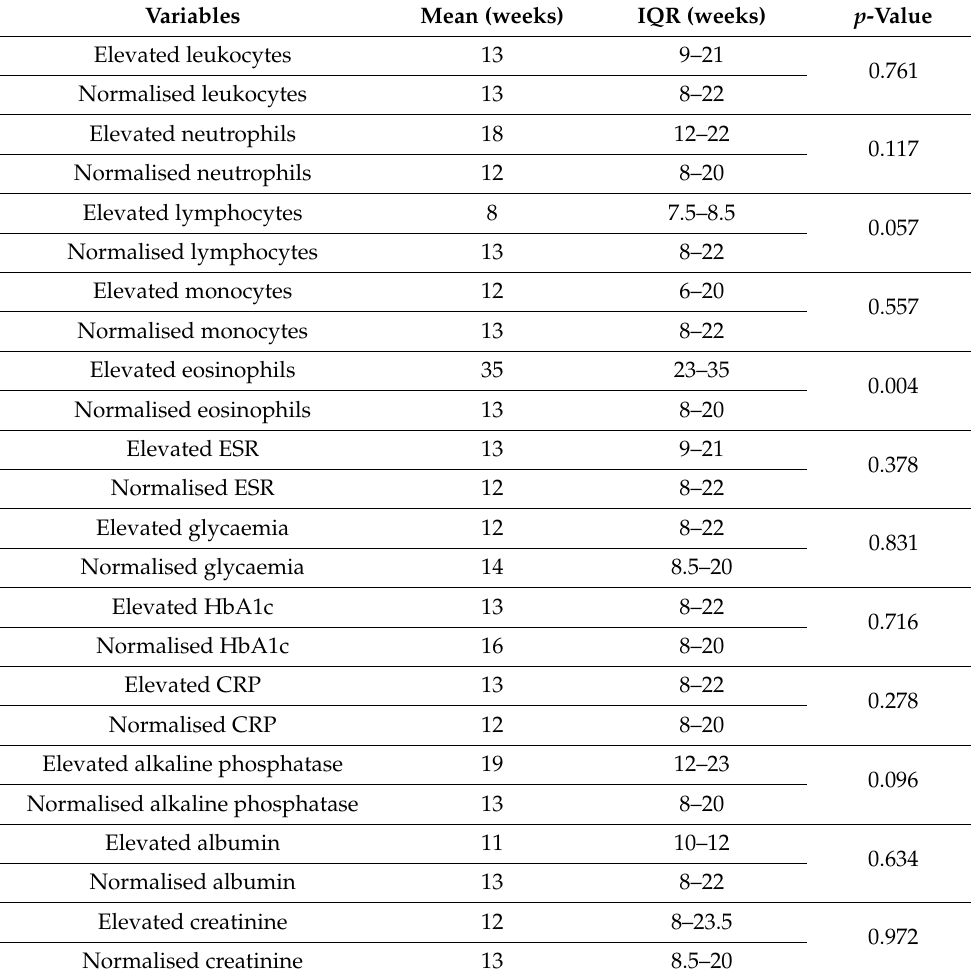
Figure 1. Kaplan–Meier survival curve for healing time in patients with elevated eosinophils. Table 2. Comparison of healing times in patients with increasing versus normal blood parameters.